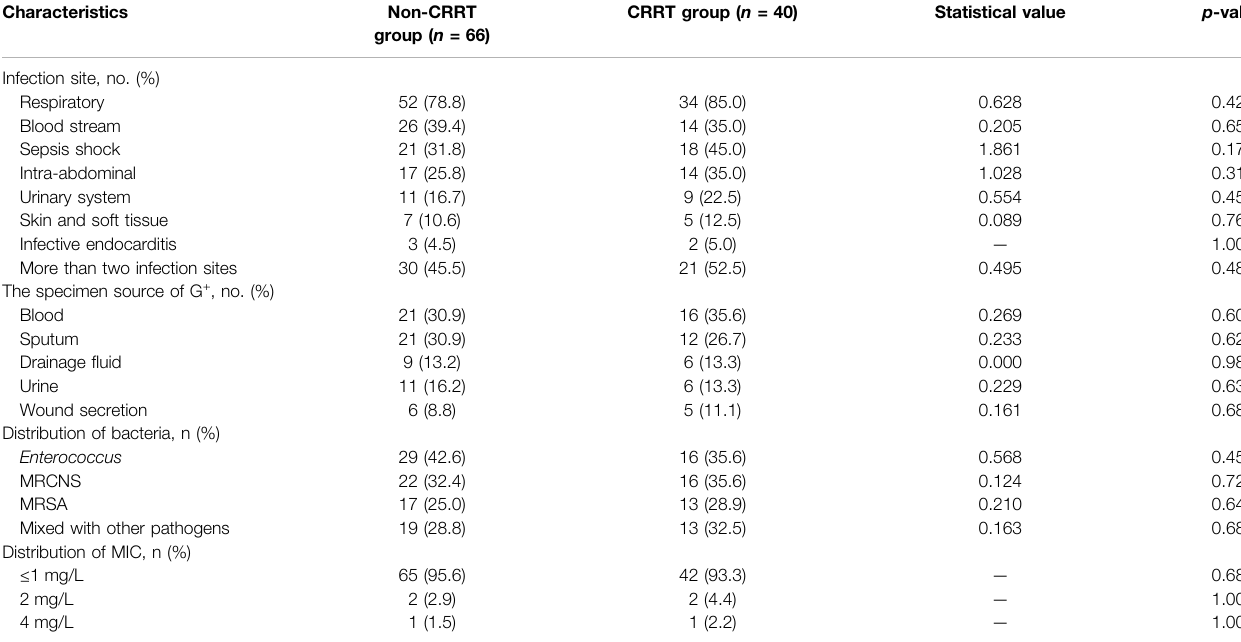
TABLE 2 | Site of infection and the distribution of Gram-positive bacteria.